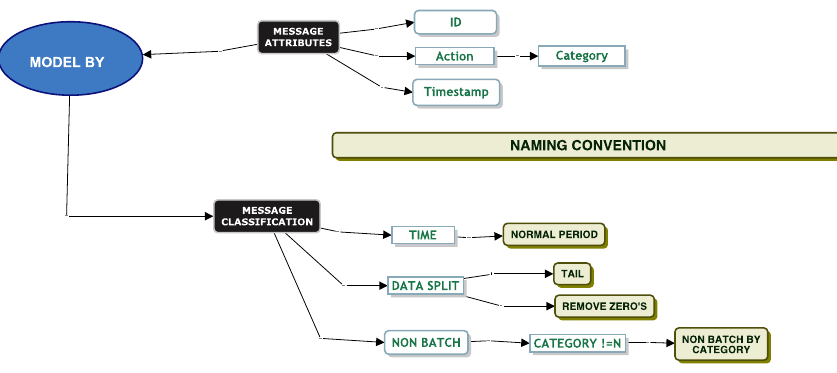
Figure 19. Non-batch by category classification model.